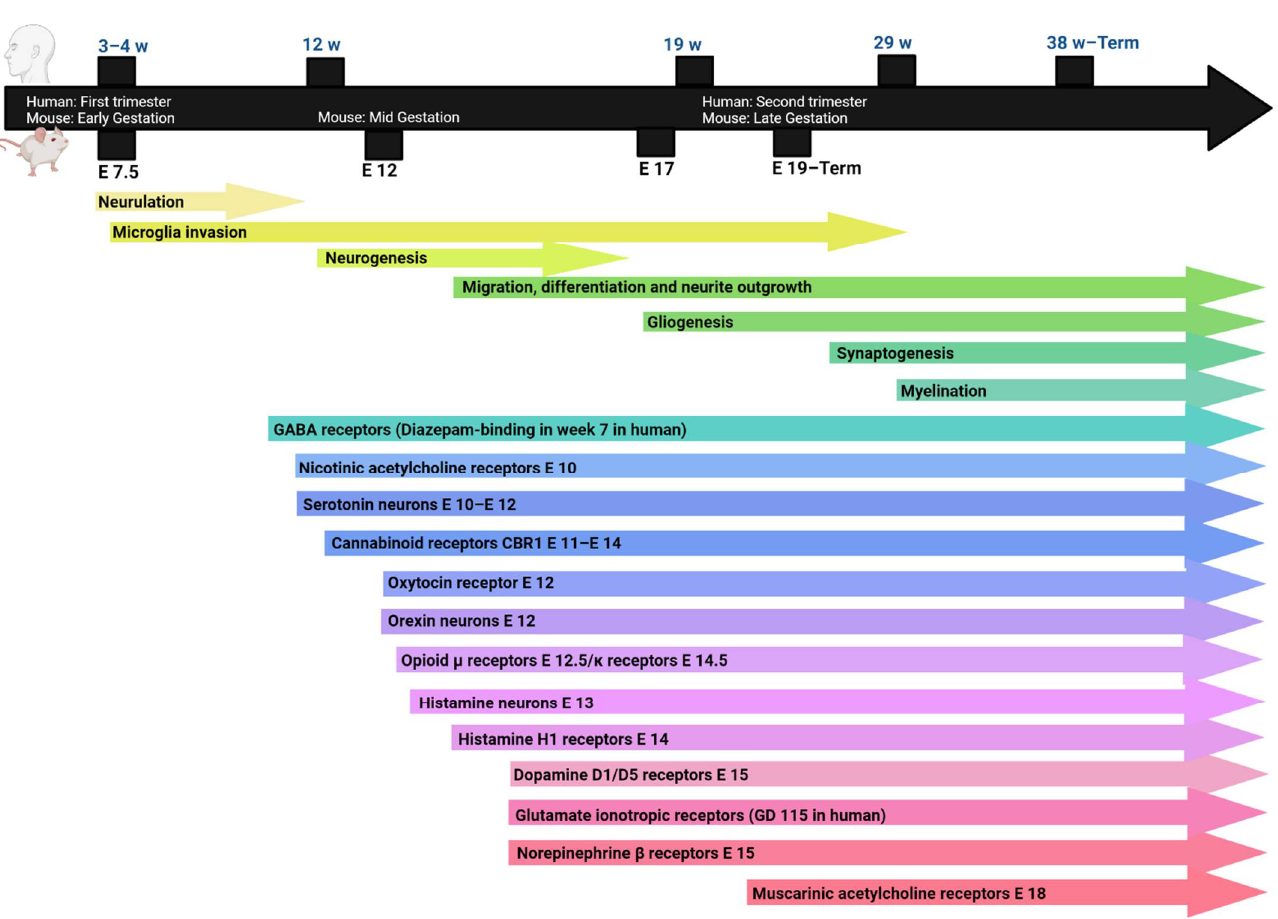
Figure 1. Timeline of ontogeny of neurodevelopment processes and neuromodulator systems in rodents and human in days. Top is the expected timeline in human in weeks. E = embryonic day in rodents. GD: gestation day in human. Each neuromodulator ontogeny E number is based on first expression of receptors and if possible, receptor binding ability. If receptor information is not available, neuron ontogeny is noted. Ontogeny related to detection of synthesizing enzymes, neu- romodulator or mRNA levels is not considered in this graph. The use of receptor ontogeny is to predict if external pharmacological agents could have any activity. Ontogeny of the neuromodulator itself could be before or after receptor ontogeny. References for each neuromodulator are as fol- lows: acetylcholine nicotinic [17], acetylcholine muscarinic [18], norepinephrine [19], dopamine [20], serotonin [21], glutamate ionotropic [22], GABA [23], histamine [24], oxytocin [25], opioid µ and κ re- ceptors [26], orexin [27,28]. The figure was created in Biorender.com and was licensed for publication in this journal.